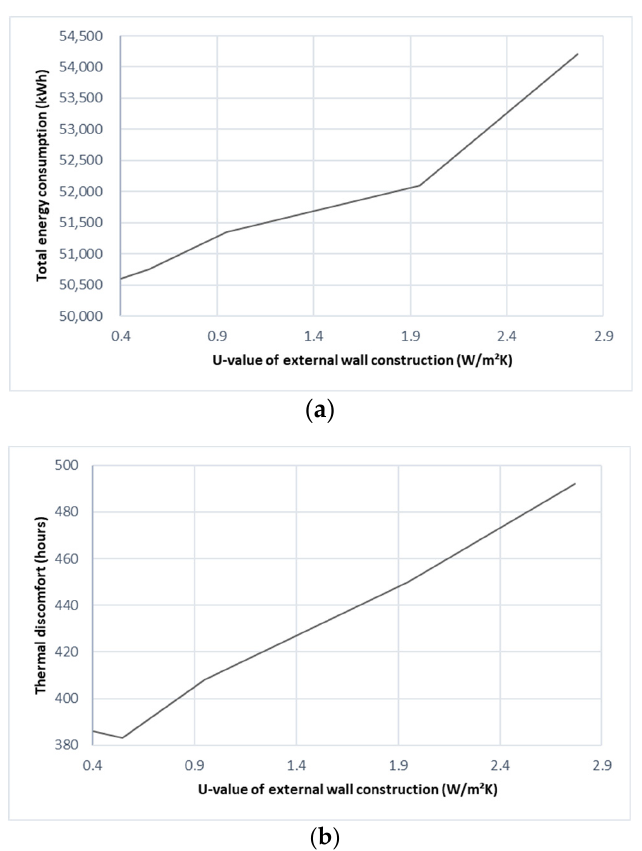
Figure 7. The effect of U-Value of external wall construction on ( a ) energy consumption. ( b ) Students’ thermal discomfort hours